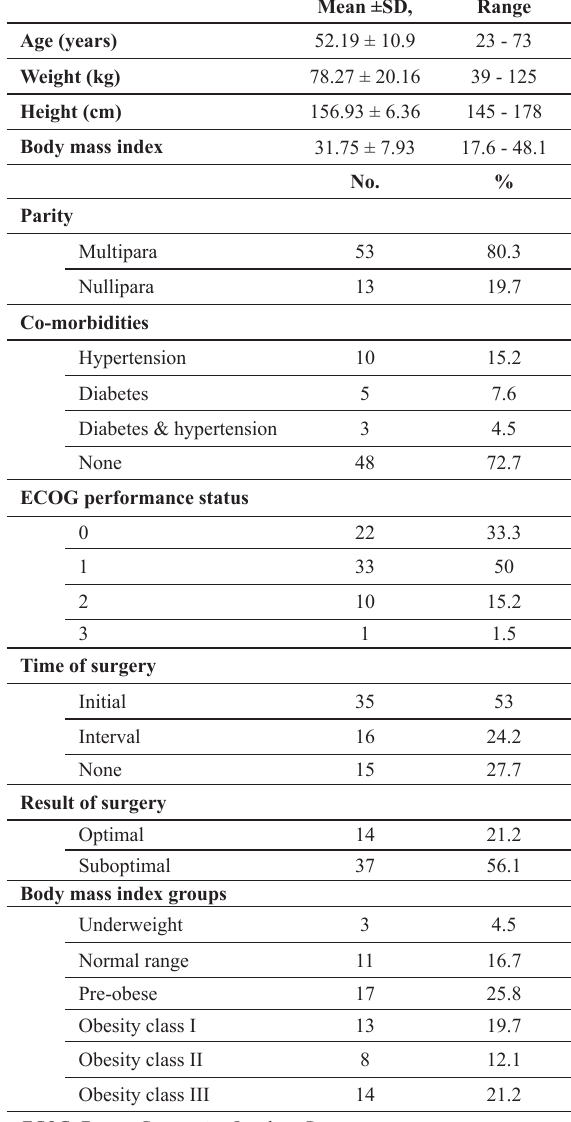
table 2: Patients'